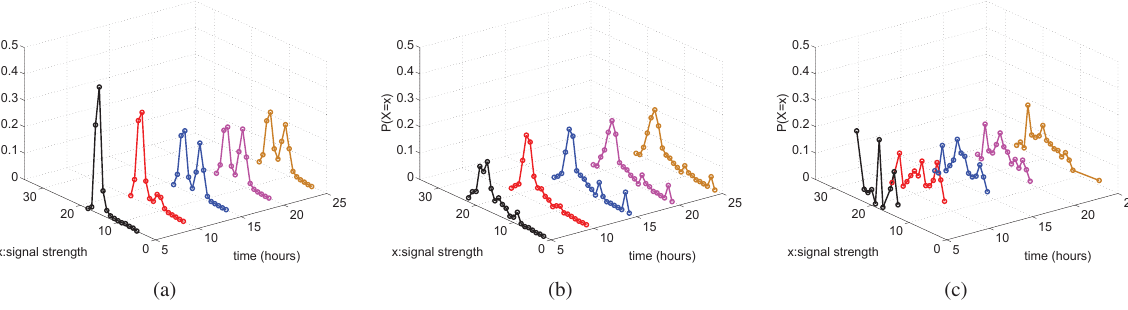
Figure 4: The evolution of signal strength distributions from the most frequently connected base station for 3 different APs are depicted in (a), (b), and (c). For each AP, the data is aggregated over time whenever connected with the AP.